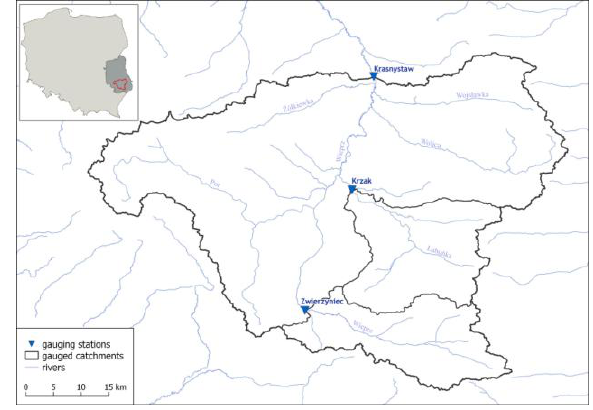
Fig. 1. Localisation of study area and gauging stations